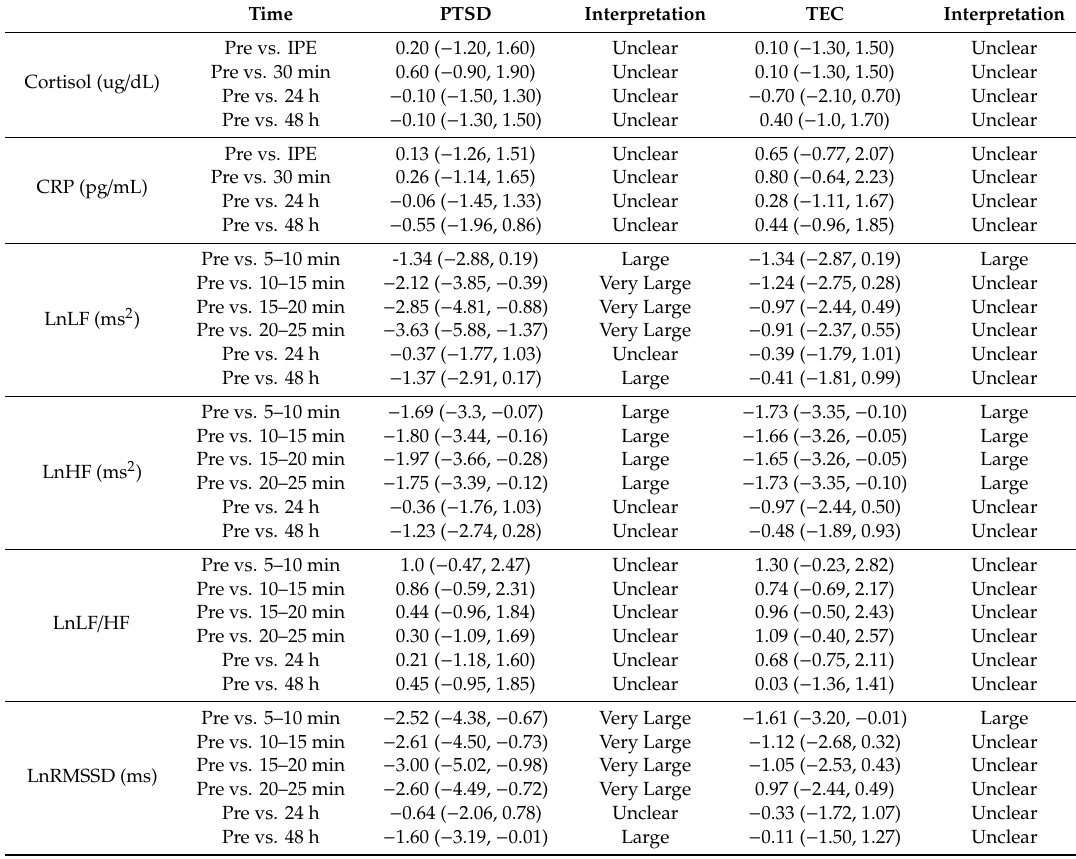
Table 3. E ff ect sizes and interpretations for salivary biomarkers and HRV parameters immediately before exercise versus follow-up